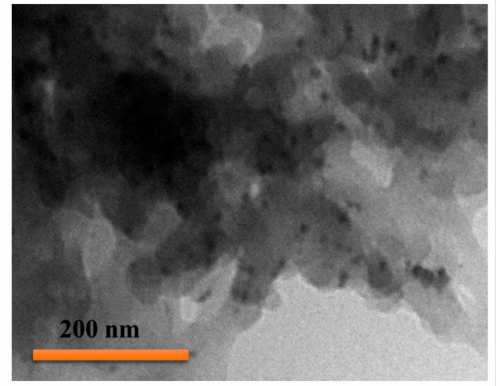
Figure 14. TEM image of the reused catalyst after seven